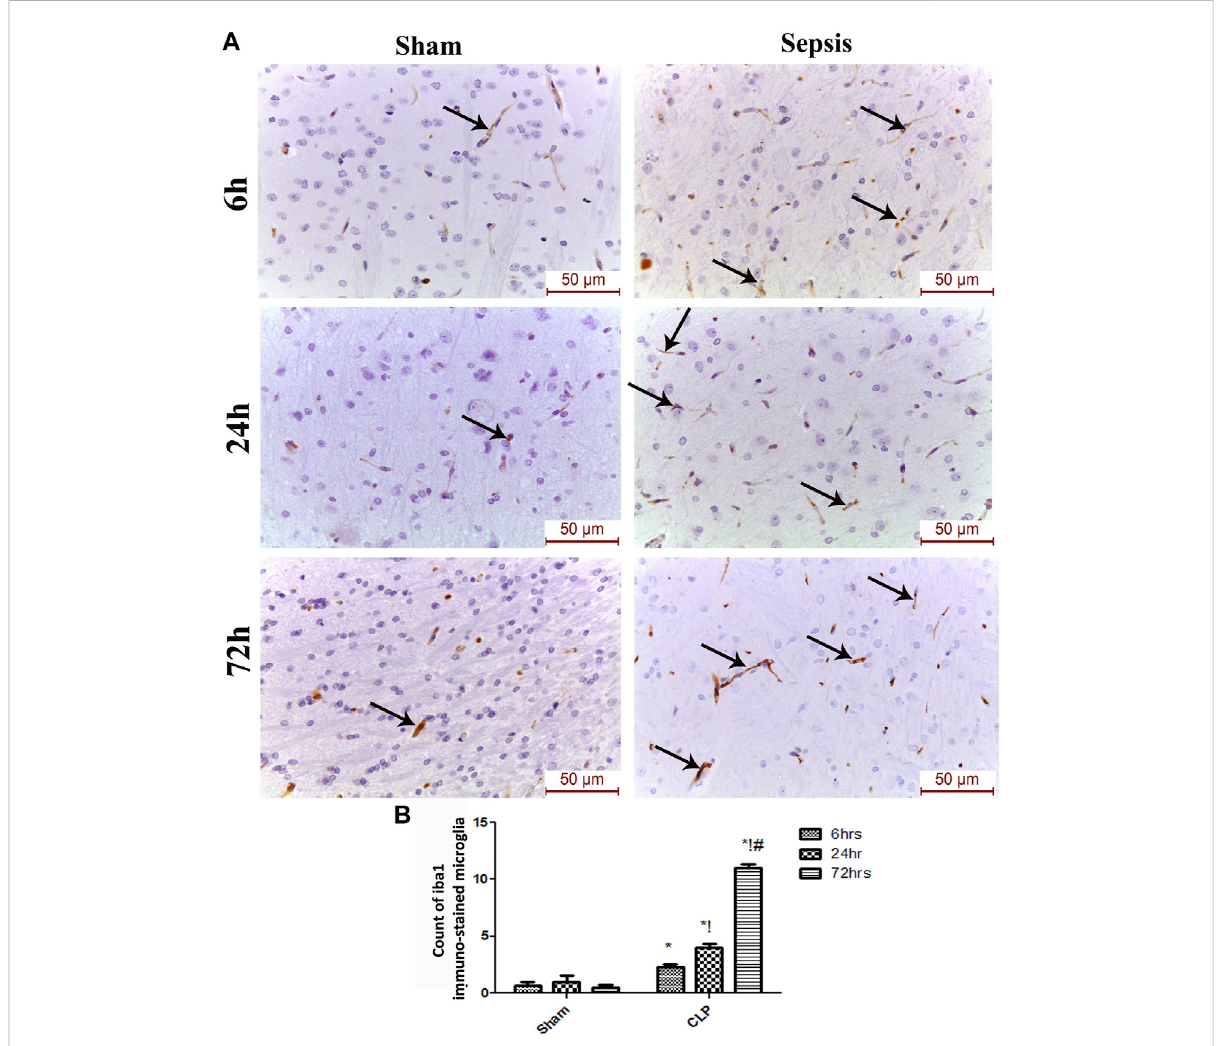
FIGURE 3 Sepsis aggravated the activation of microglia. (A) Immunohistochemical evaluation of Iba1 expression in the sham and cecal puncture and ligation (CLP) groups at different time points. (B) Count of Iba1 immunohistochemically stained microglia. Data are presented as the mean ± S.E.M. ( n = 6). *: Statistically signi fi cant vs. the Sham; !:signi fi cant vs. 6 h CLP; #: signi fi cant vs. 24 h CLP using ANOVA with the Bonferroni post-hoc